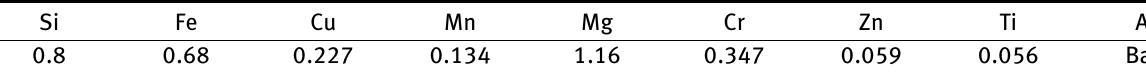
Table 2: Mechanical properties of AA 6061-T6 aluminium alloy Tensile stress Yield stress Elongation (%) (MPa) (MPa) 348 254 11.5